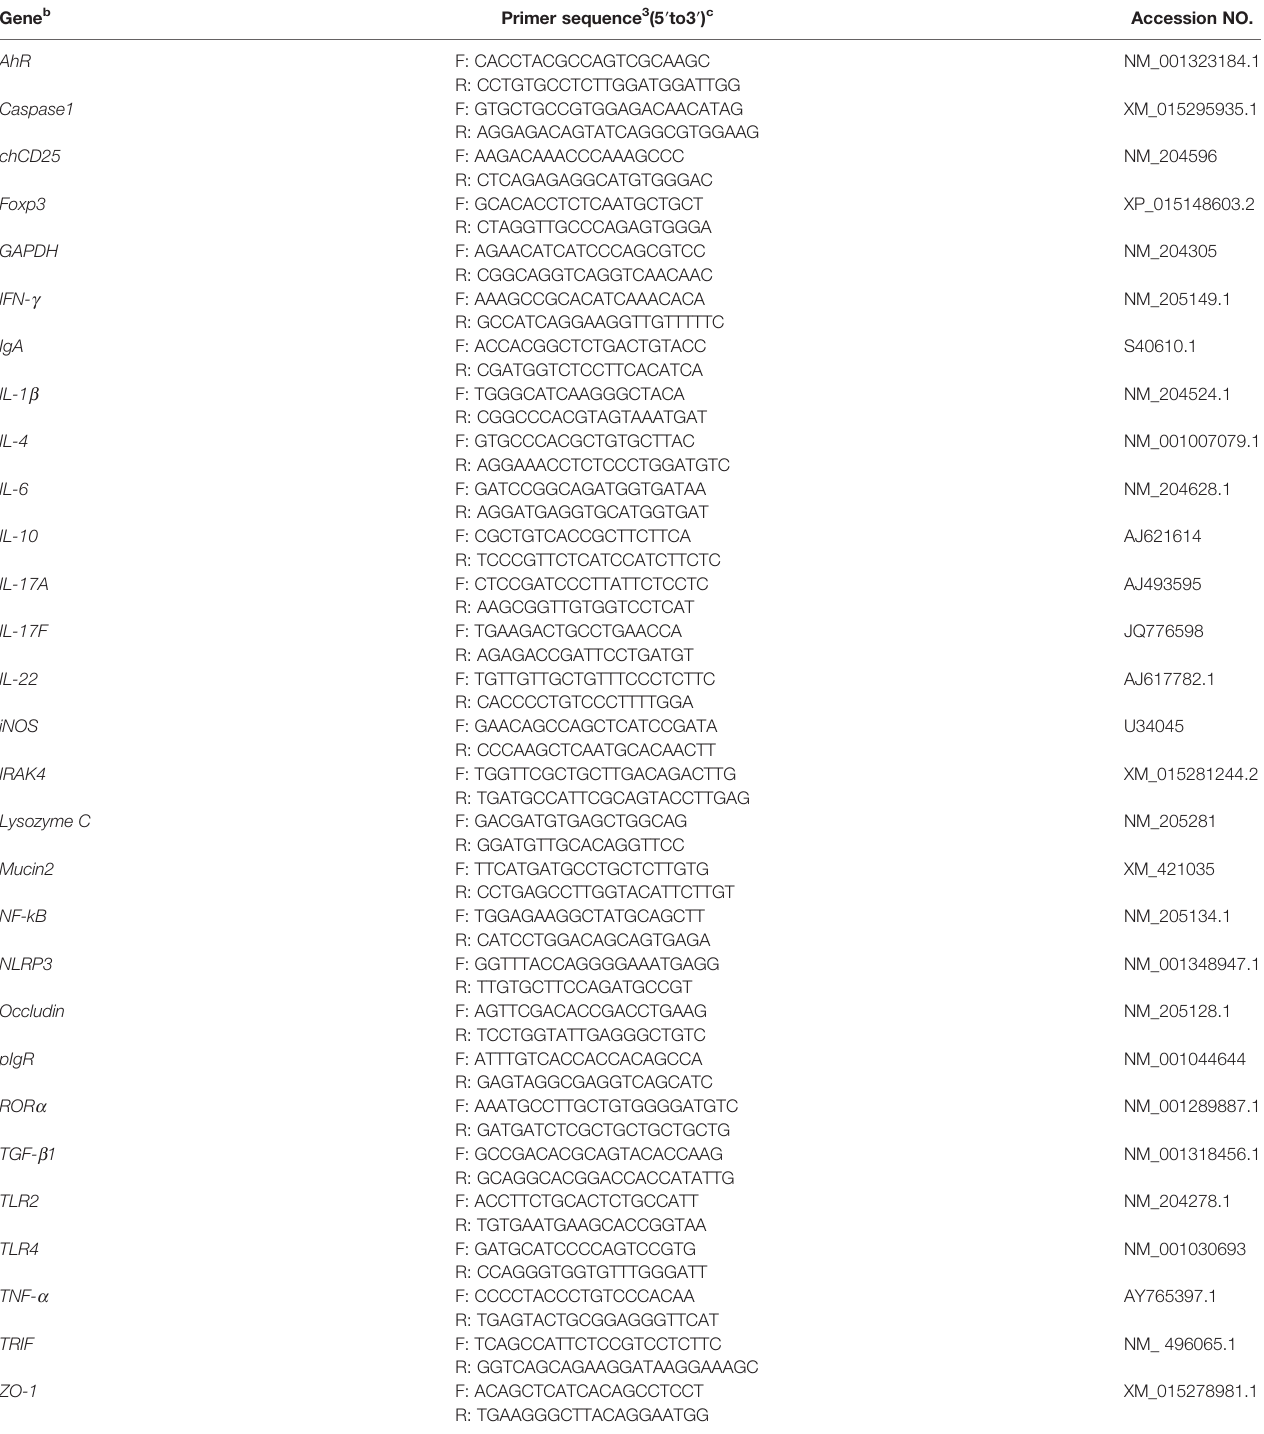
TABLE 2 | Sequences of the oligonucleotide primers used for quantitative real-time PCR a . Gene b Primer sequence 3 (5 ′ to3 ′ )